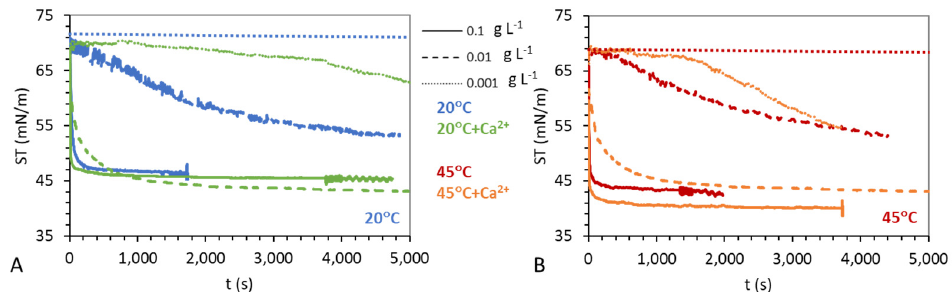
Figure 7. Dynamic surface tension of adsorption of mGel − onto the air-water interface at constant surface area and for different mGel − concentration, temperature and subphase: 0.1 g L − 1 (solid line), 0.01 g L − 1 (dashed line), 0.001 g L − 1 (dotted line). ( A ) Swollen microgels, 20 °C in water (blue), in 1 mM Ca(NO 3 ) 2 (green). ( B ) Shrunken microgels, 45 °C in water (red), in 1 mM Ca(NO 3 ) 2 (orange). Plotted values are mean of at least three experiments, being the standard deviation below ± 2 mN/m.